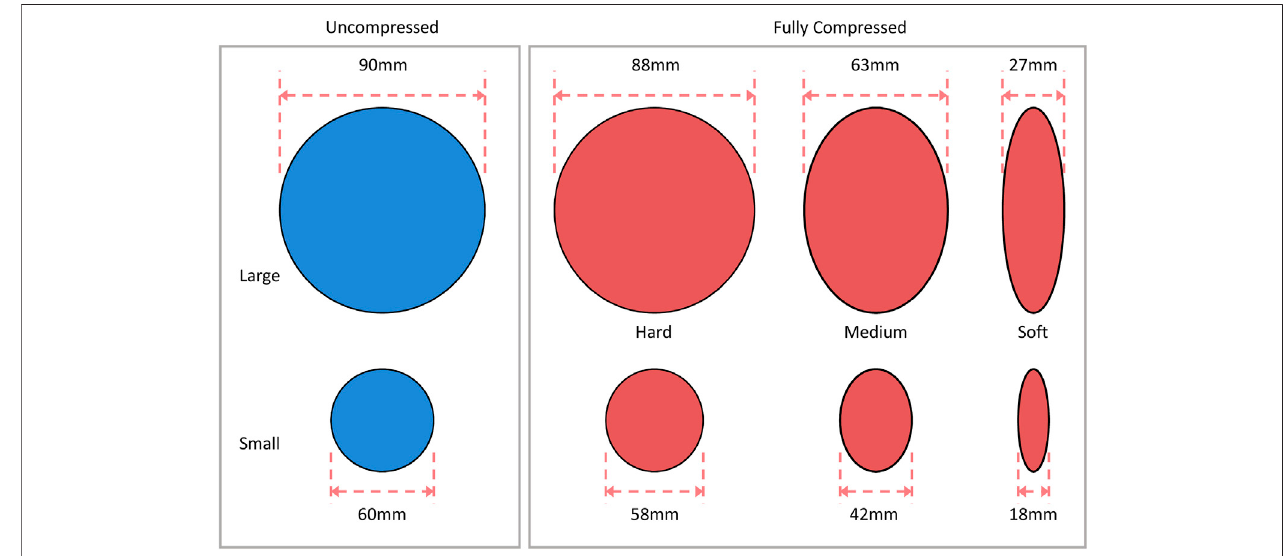
FIGURE 3 | Virtual object pro fi les used during the classi fi cation task. Six pro fi les were created from combinations of two sizes and three compliance levels. The maximum compression distance of each object, which is dependent on the compliance of the object, is presented.